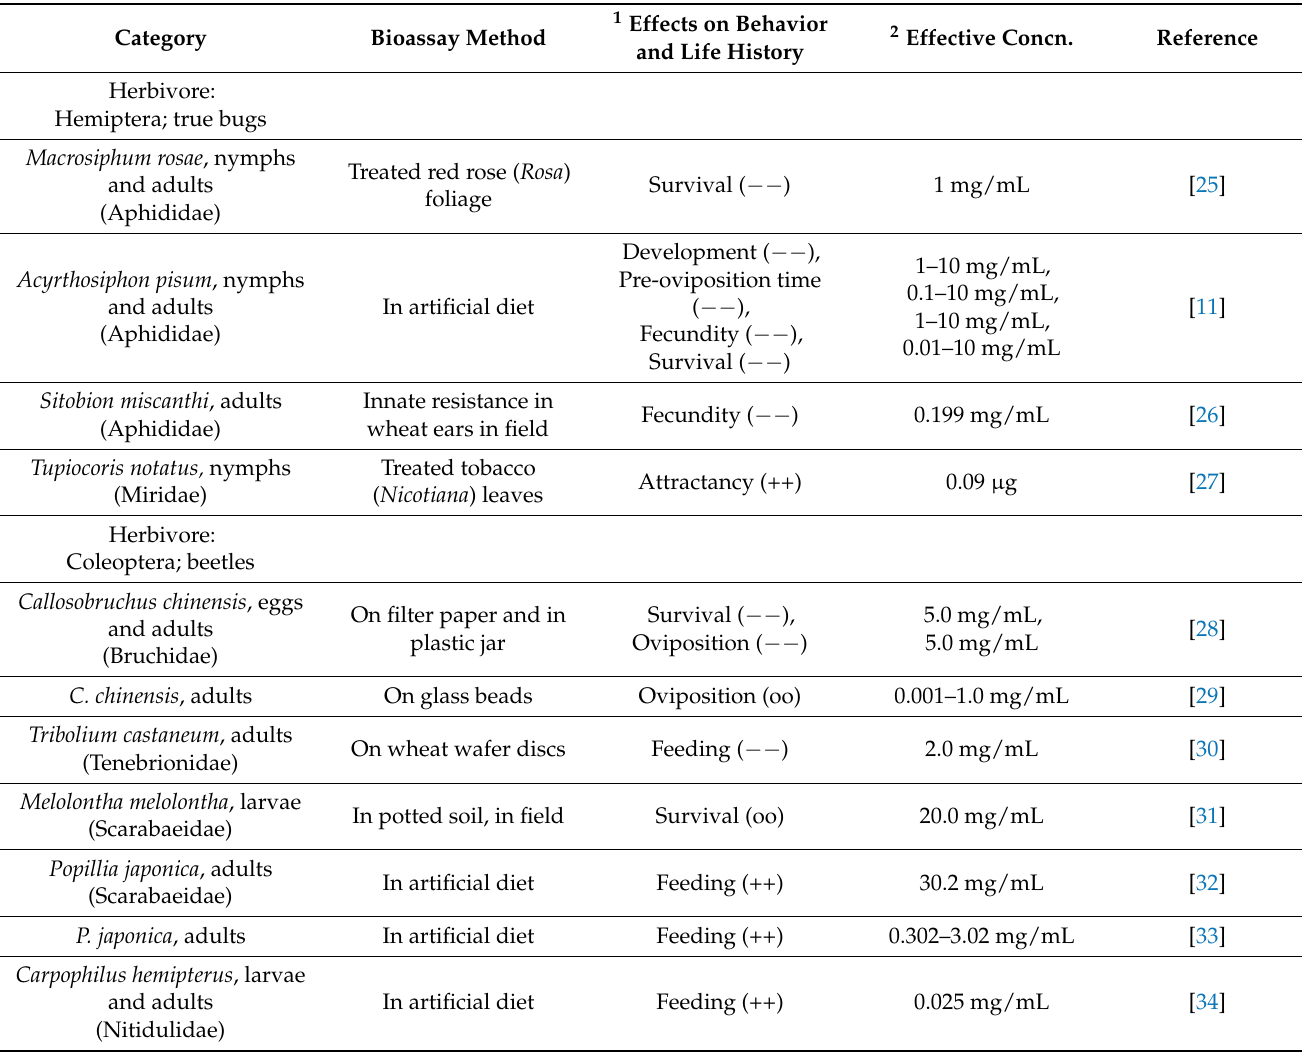
Table 1. Exemplary research that tested the effects of quercetin on behavior and life history parameters of agriculturally important insect herbivores. Category Bioassay Method